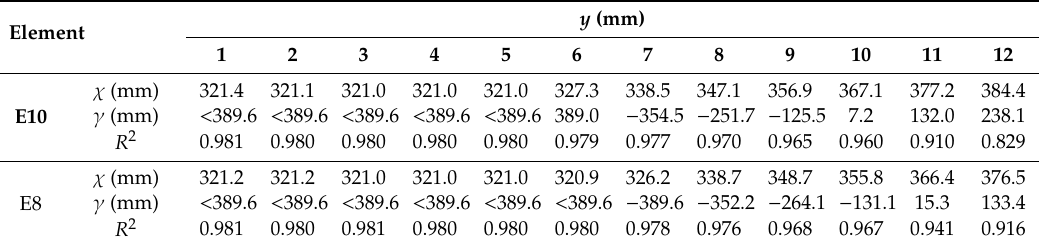
Table 15. The strain on the bolts at each loading step in E10 (unit: µε ). Bolt